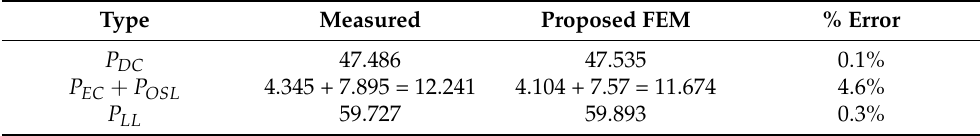
Table 7. Measured rated losses (kW)—Case